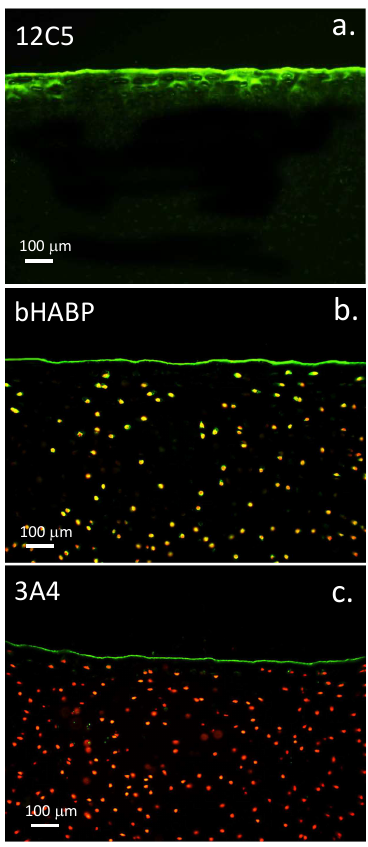
Figure 9. Immunolocalisation of versican in the surface regions of tibial plateau bovine articular cartilage ( a ) immobilises HA at the cell surface ( b ). This is visualised using biotinylated HABP and avidin-FITC. Lubricin is also a component of the surface lamina of articular cartilage ( c ) and has roles in joint lubrication acting synergistically with HA and other proteins such as fibronectin and pentraxin-3 which aid in joint lubrication. ITI SPIs are also attached to HA and these protect the cell surface lubricin. HA is also visualised intra- and pericellularly in the articular chondrocytes ( b ). Cell nuclei were stained with propidium iodide in b and c. HA was visualised using bHABP/avidin-FITC. The fluorescent images were visualised by confocal microscopy using a Leica TCS SP2 AOBS laser scanning confocal microscope using a 40 × oil immersion objective. The slides were scanned using excitation and emission settings for Alexa 488 of (Ex max: 488; Em max: 520) Z-stacks of 8-bit ‘optical sections’ (512 × 512 pixels) were taken through the full cartilage thickness at in 0.4 µ m increments. ‘Maximum Intensity’ reconstructions were prepared from the image stacks using Leica Confocal Software (Leica, Heidelberg, Germany).